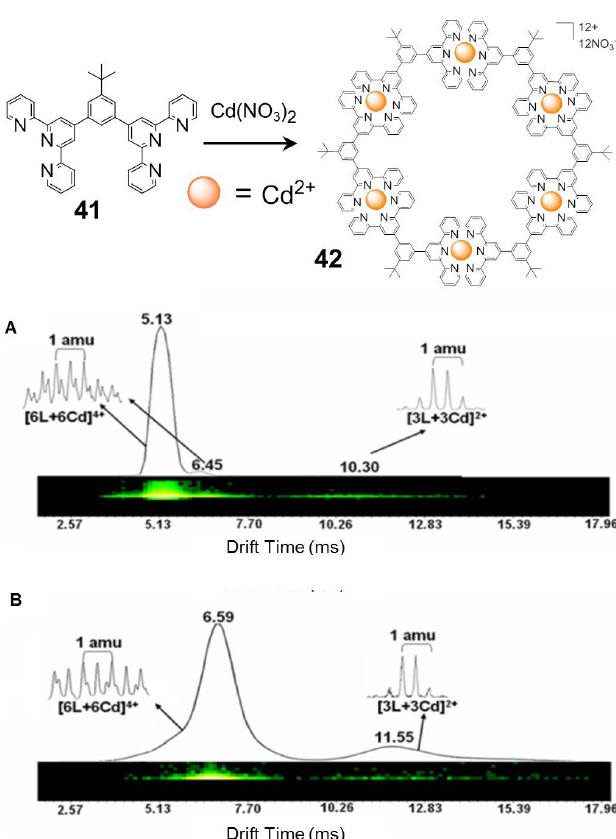
FIGURE 18 – Quantitative synthesis of a Cd-based hexamer 42 . Its 2D ESI-TWIM-MS signals (7A) for m/ z 1187 amu compared to the same ion fragments generated from a similar linear Cd construct (7B) [Chan, Y.-T.; Li, X.; Soler, M.; Wang, J.-L.; Wesdemiotis, C.; Newkome, G. R. J. Am. Chem. Soc. , v.131, p.16395-16397, 2009 – Reproduced by permission of The American Chemical Society].